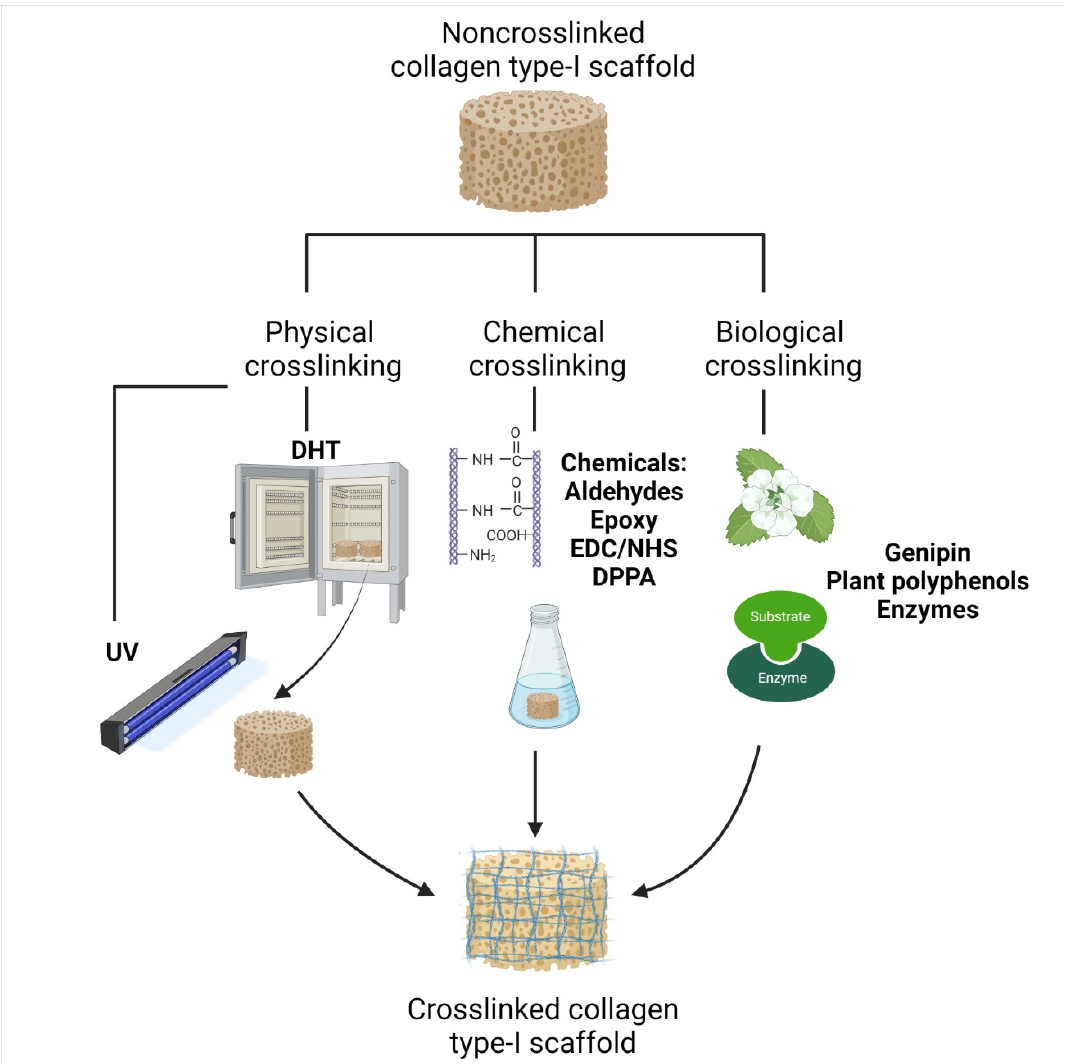
Figure 5. Illustration of different techniques for crosslinking collagen type I scaffolds. Physical crosslinking includes physical alterations, usually from DHT heat treatment or UV irradiation. Chemical crosslinking refers to chemical alterations using aldehydes such as glutaraldehyde, epoxy compounds, commonly used EDC/NHS crosslinking, and DPPA. Biological crosslinking uses materials derived from biological sources such as genipin, a plant-based crosslinker, plant polyphenols, and